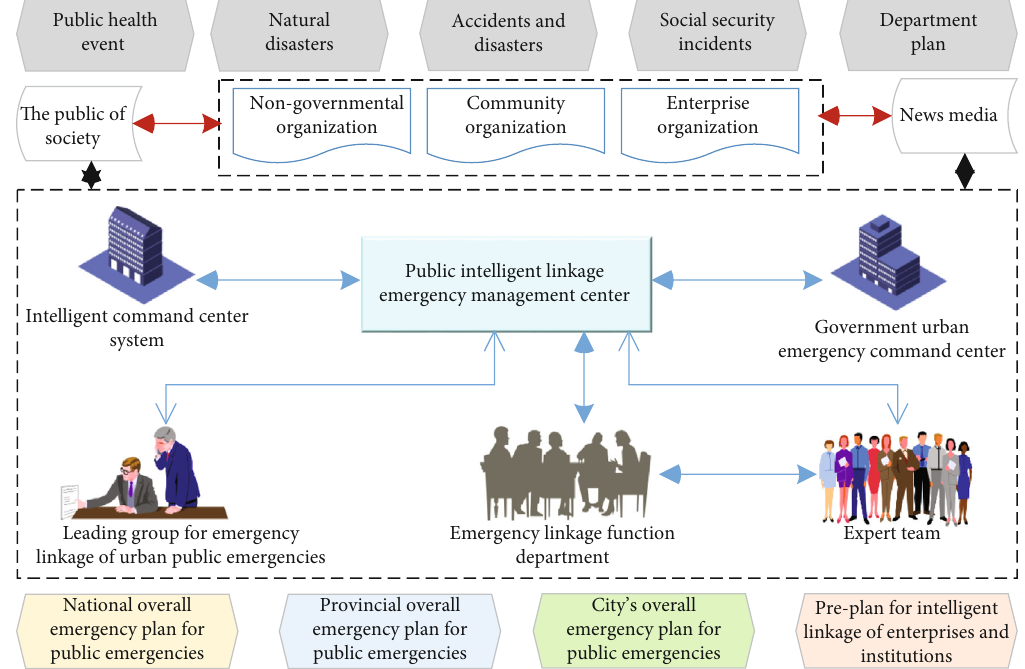
Figure 2: The structure of the government ’ s urban public management emergency linkage early warning organization